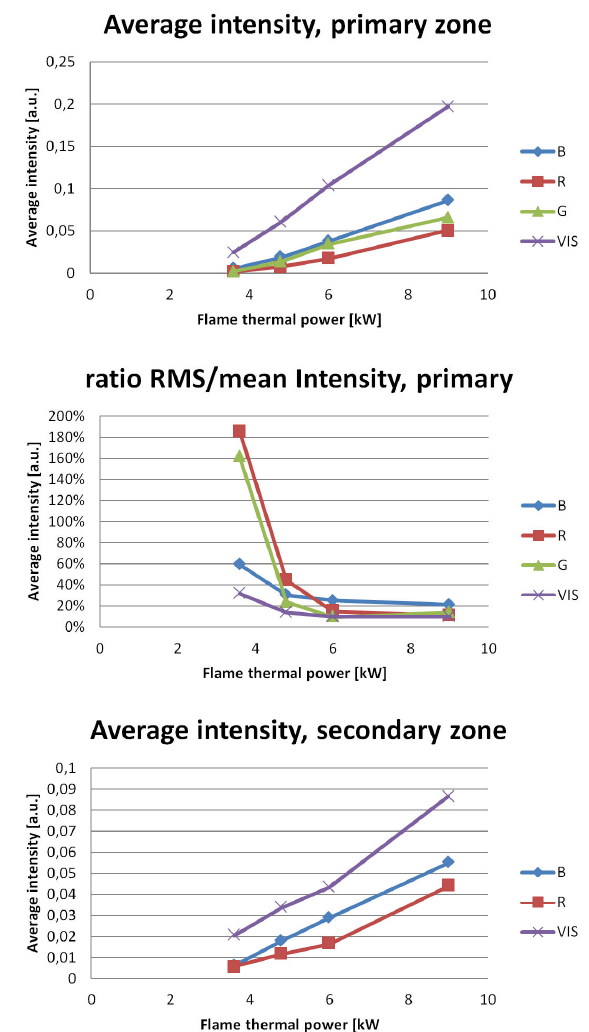
Figure 17. RGB measurements using the combined probes: ( top and middle ) average and RMS/average profiles in the primary zone and ( bottom ) secondary